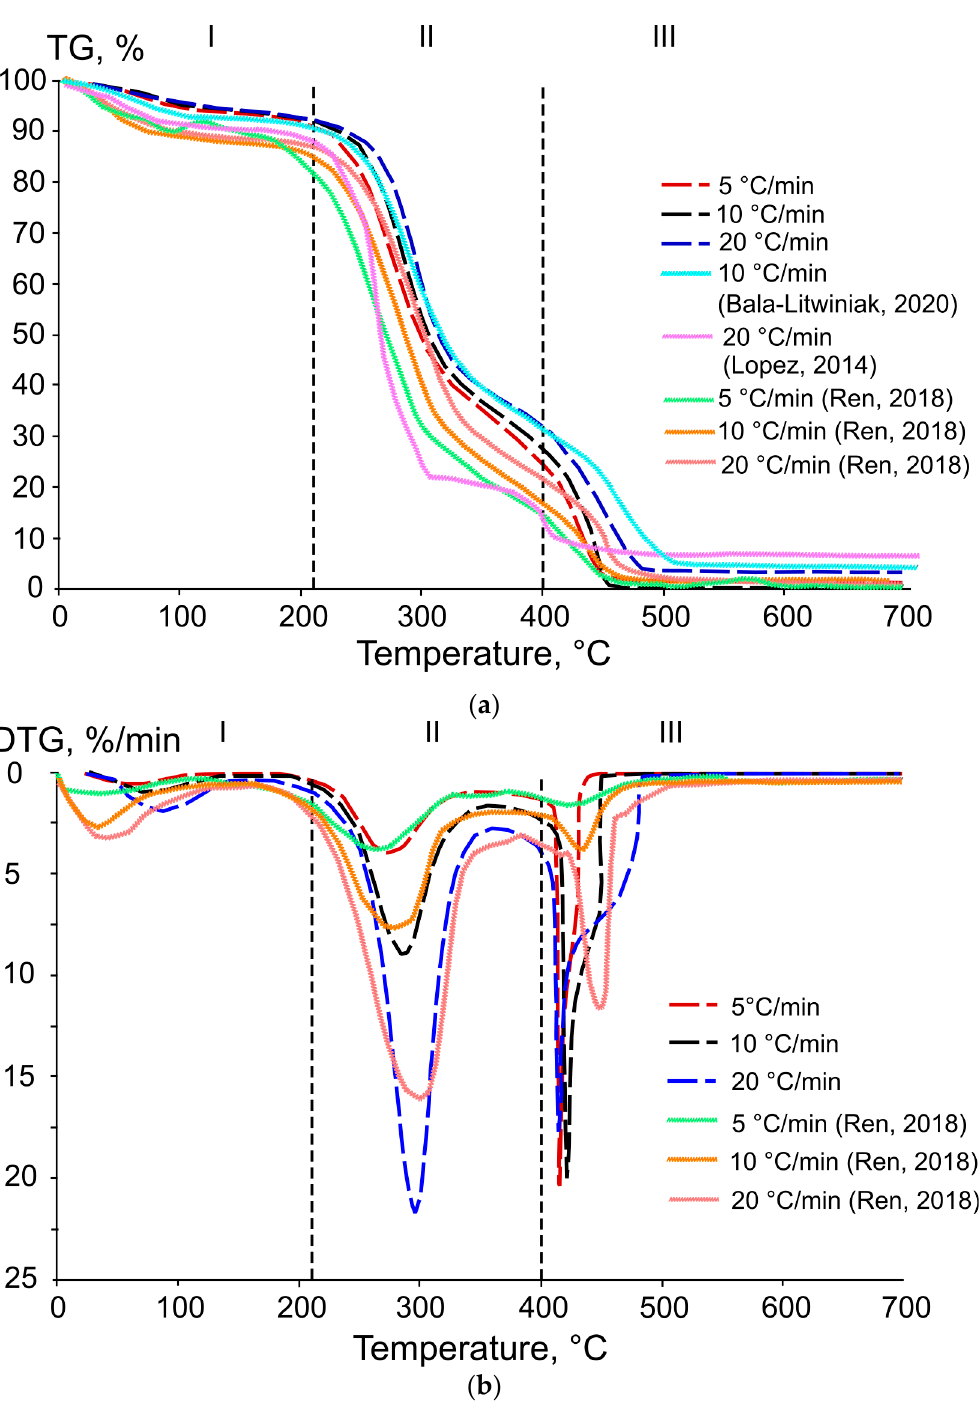
Figure 2. ( a ) TG and ( b ) DTG curves for sunflower husk: blue line [5], pink line [26], light green, orange, and coral line [27].